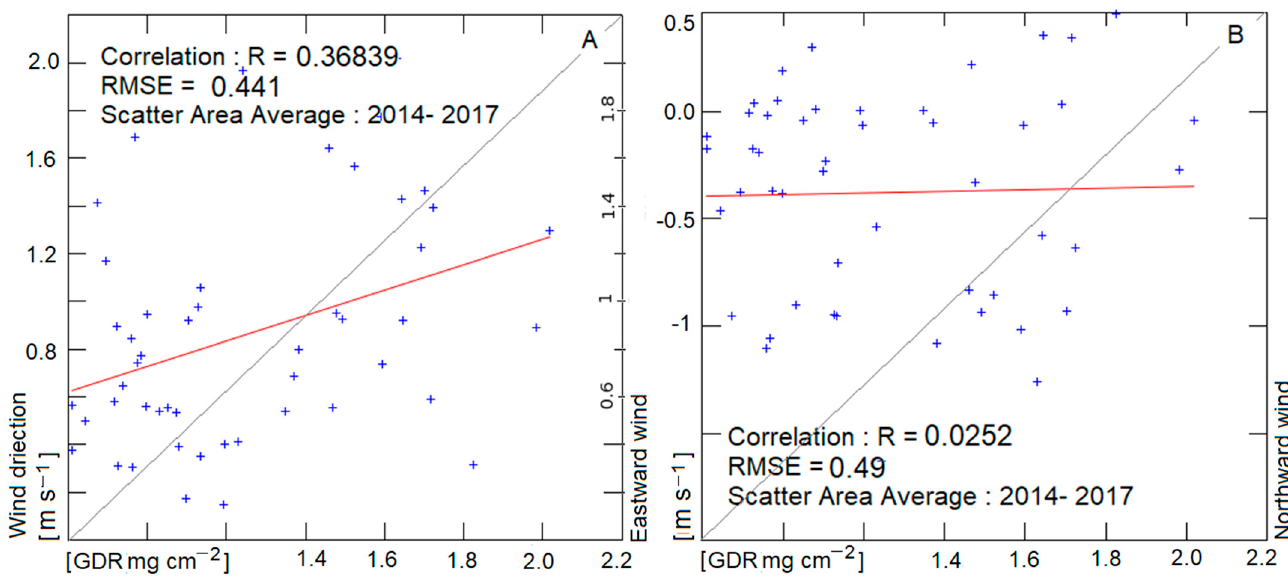
Figure 13. Correlation of wind velocity versus the eolian deposition rate. ( A ) Eastward; ( B ) Northward. Left : Correlation plots for eastward wind speeds (m s − 1 ) versus ground deposition rate (GDR) and Root Mean Square Error (RMSE) during the period 2014–2017. Right : Correlation plots for northward wind speeds (m s − 1 ) versus GDR during the period 2014–2017.